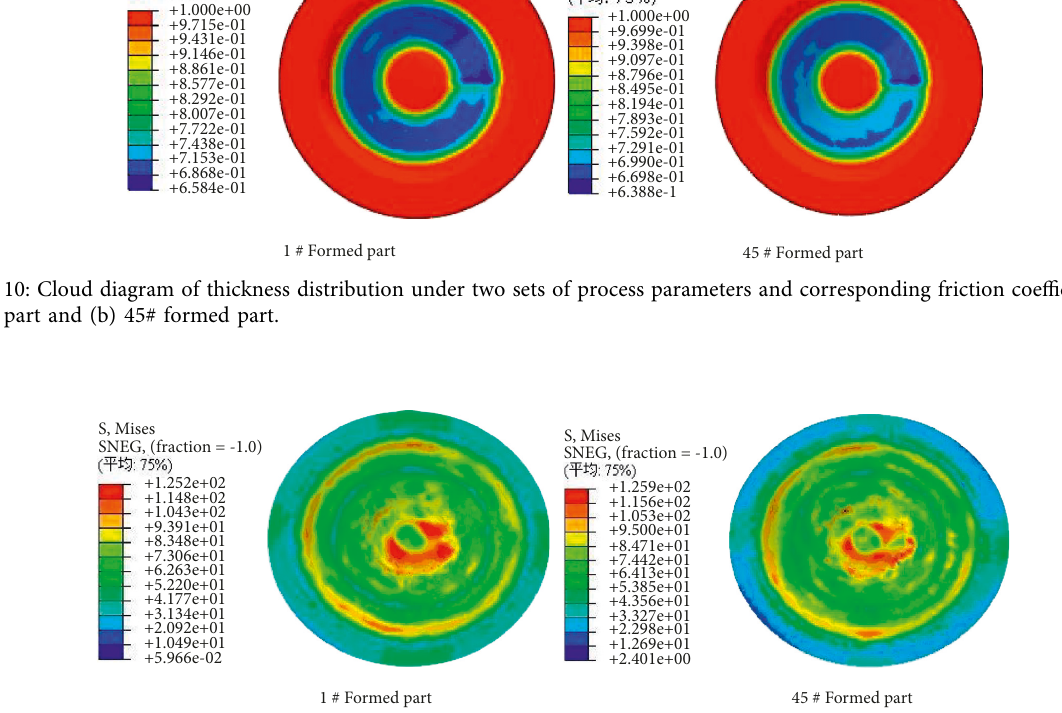
Figure 11: Cloud diagram of equivalent stress under two sets of process parameters and friction coefficient: (a) 1# formed part and (b) 45# formed